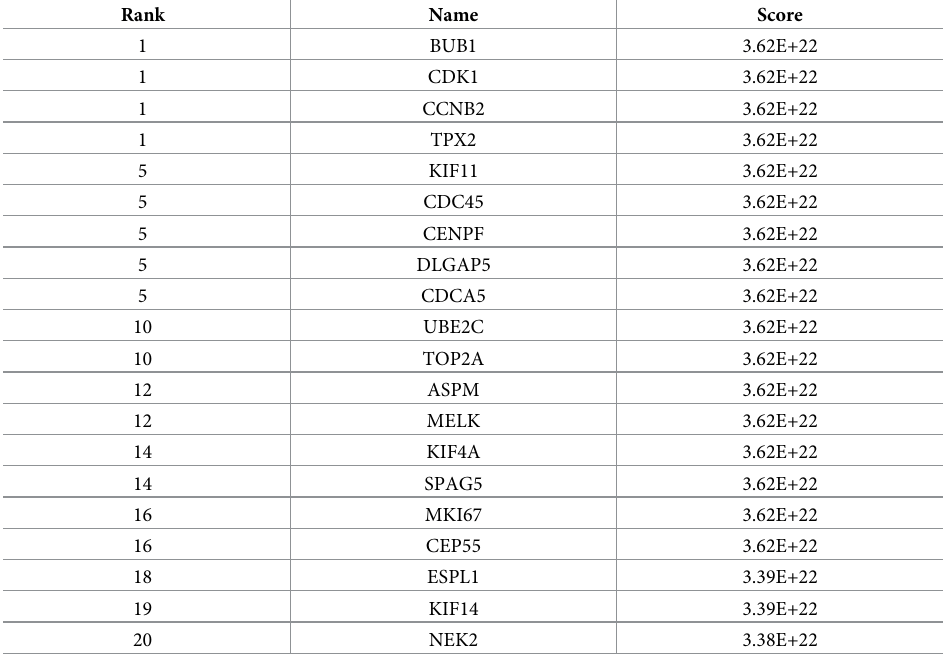
Table 1. Top 20 hub genes in network ranked by MCC method.